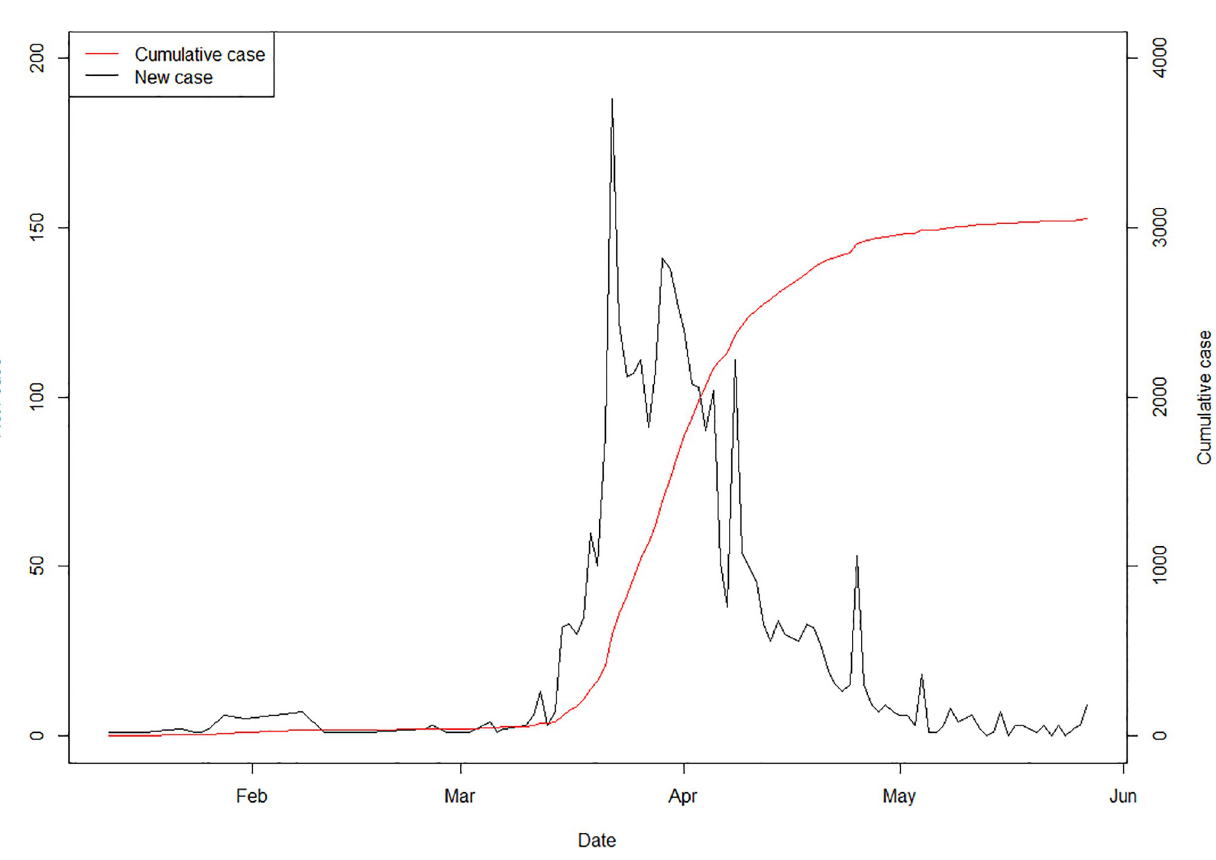
Fig 1. New and cumulative COVID-19 cases in Thailand by report